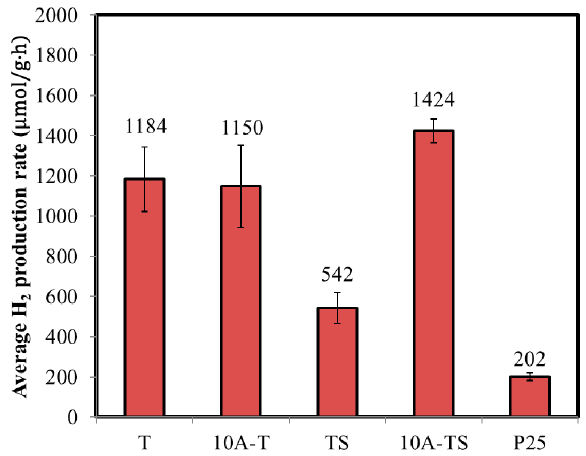
Figure 8. The average hydrogen production rate with 10 vol.% CH 3 OH in the 6 h photocatalysis reaction.